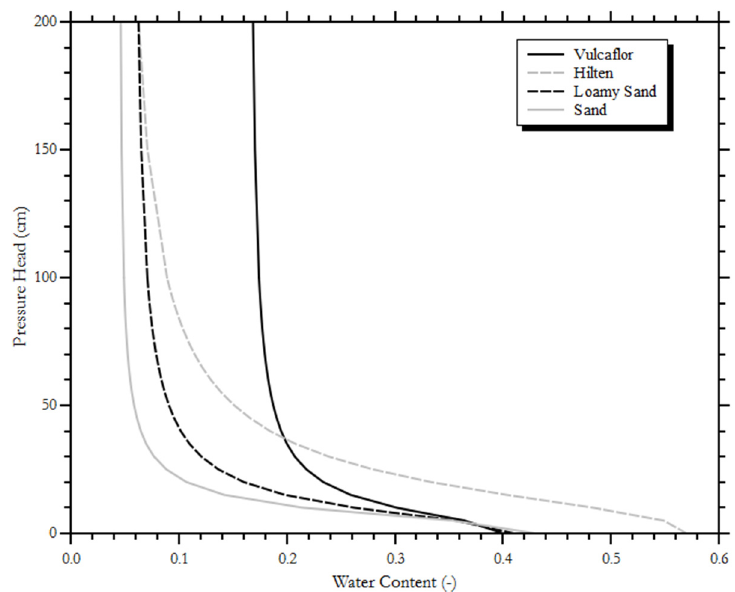
Figure 6. Retention curves for selected soils.